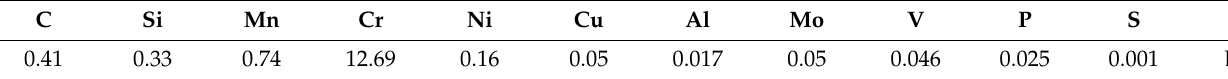
Table 1. Chemical composition (wt.%) of AISI 420 martensitic stainless steel.